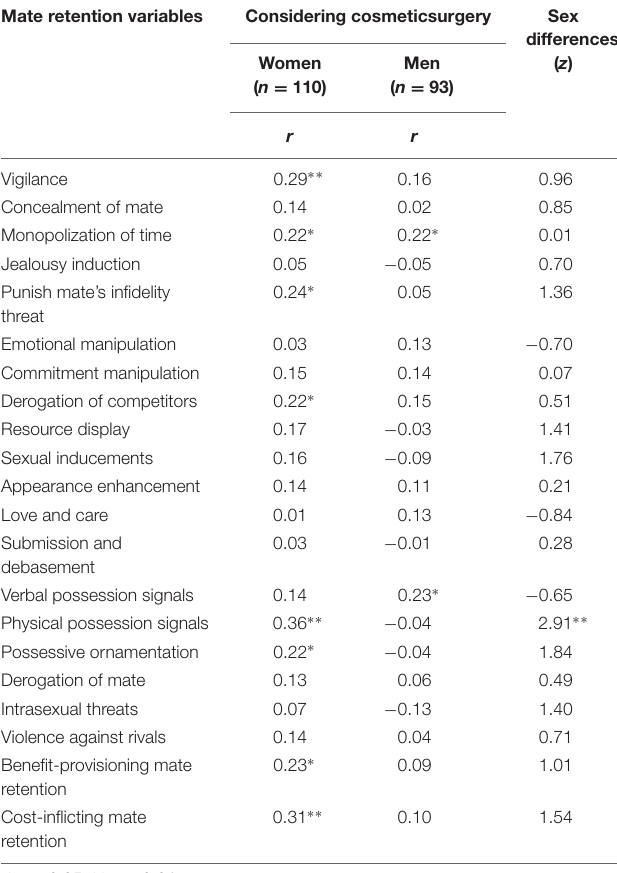
TABLE 1 | Associations between mate retention variables and considering cosmetic